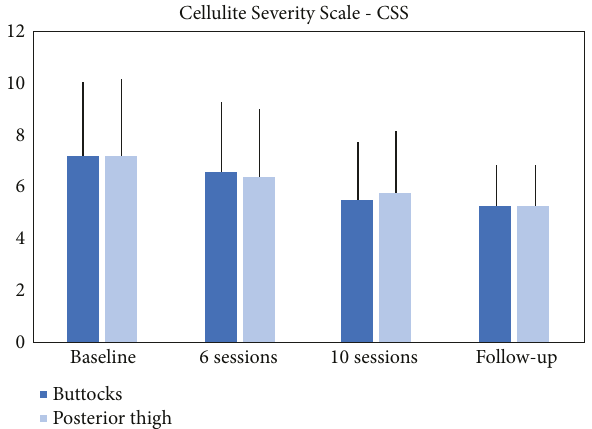
Figure 1: Improvement in the severity of cellulite between the initial evaluation, reevaluations, and follow-up of 3 months from the end of the